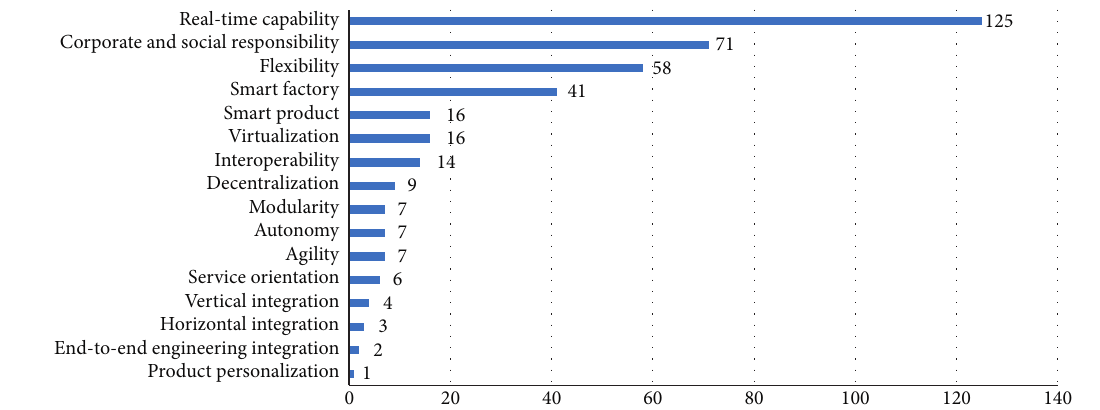
Figure 8: Linking optimization to the requirements and characteristics of Industry 4.0.